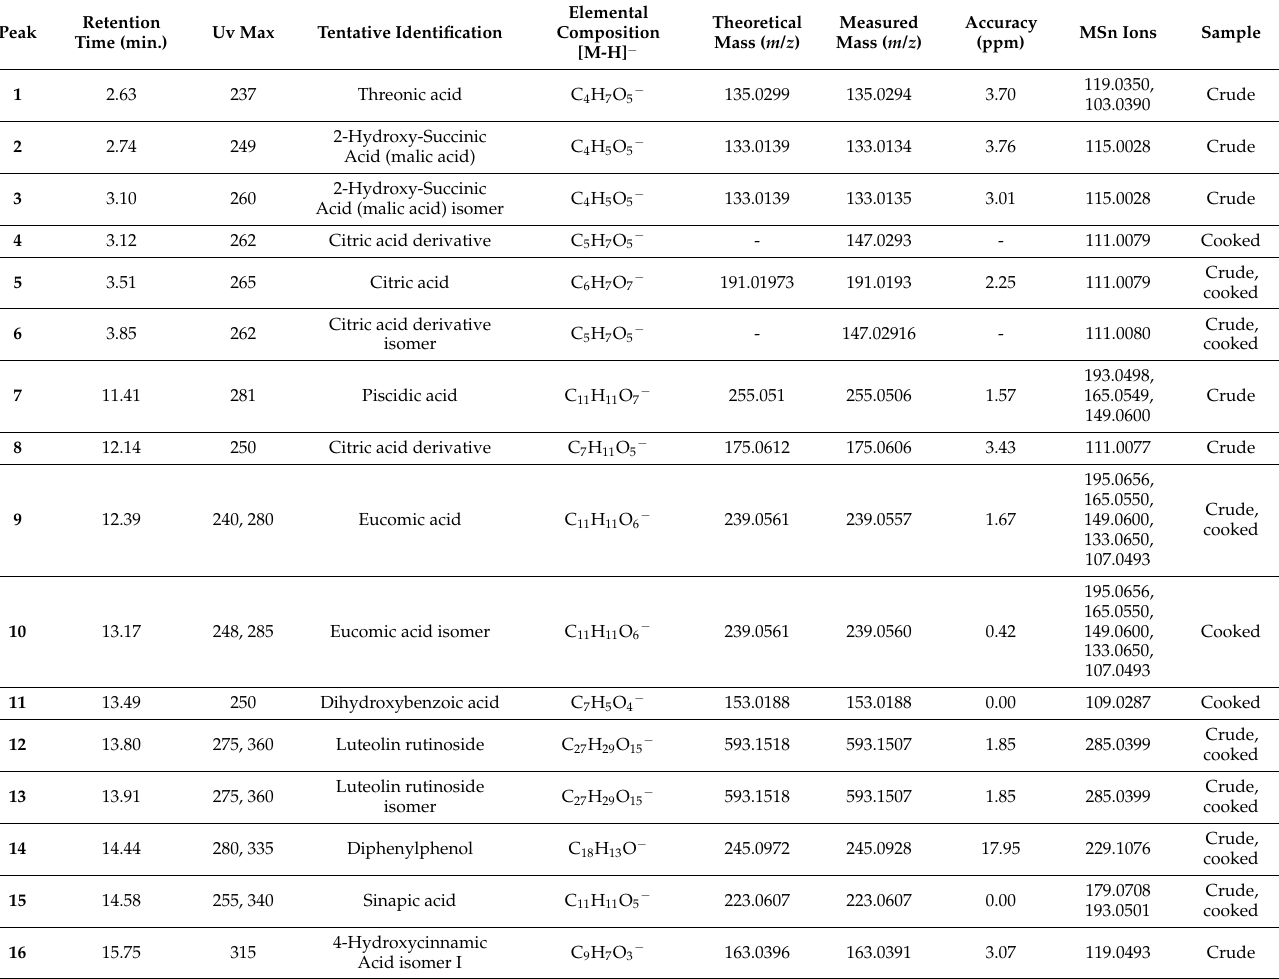
Table 2. Metabolites identified in cooked and crude young stems of A. tetragonus by UHPLC-PDA-